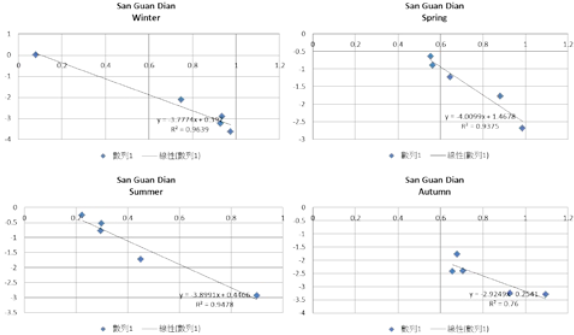
Figure11 、 The function of seasons of San Guan Dian